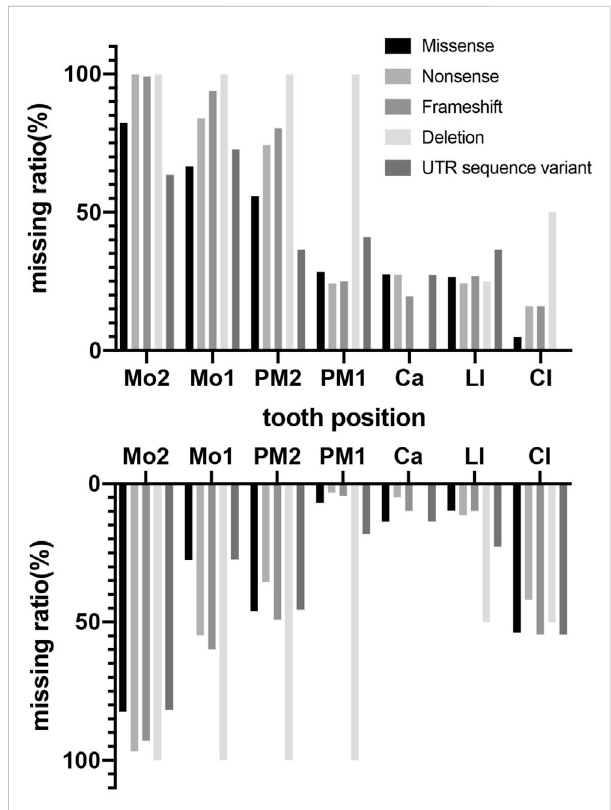
FIGURE 6 Percentage of missing teeth with different variant type in maxillary and mandibular arches in patients with non-syndromic oligodontia ( n = 151) caused by PAX9 gene variants.